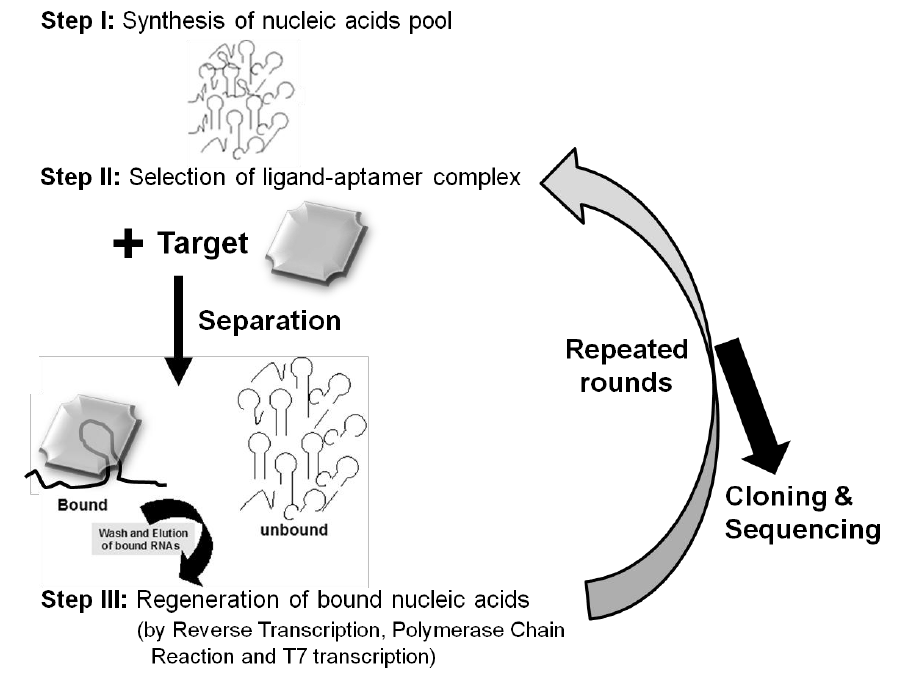
Figure 2. Representation of SELEX process. A specific molecule is selected from a randomized library using separation and regeneration processes. Nucleic acid pool sizes are generally ranging from 25 to100 bases. The selection procedure separates low-affinity binders and the regeneration procedure increases the number of the bound nucleic